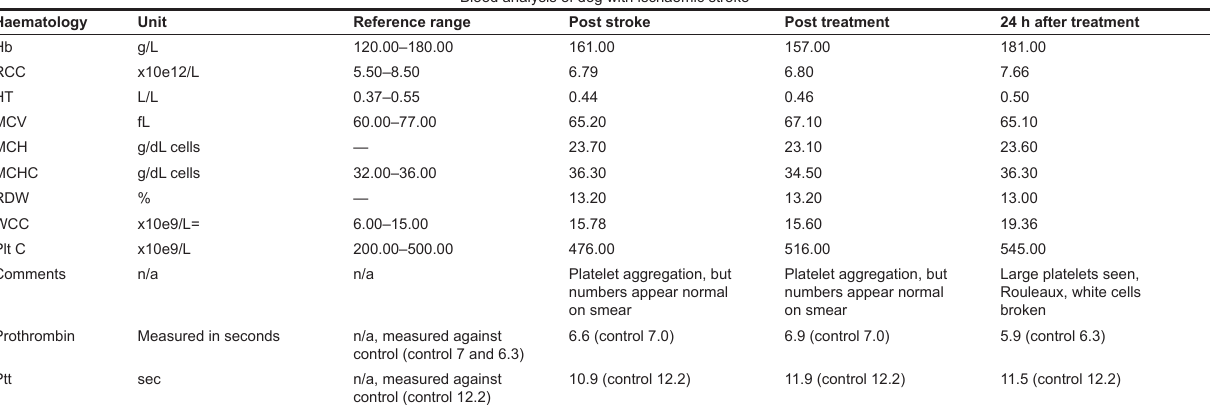
TABLE 1 Blood analysis of dog with ischaemic